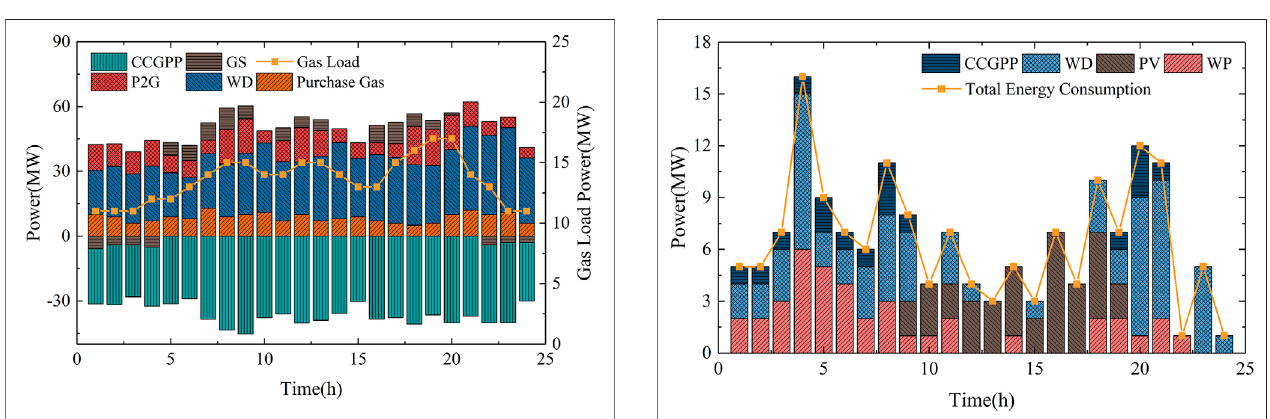
FIGURE 8 | Gas balance curve of Scene 4.